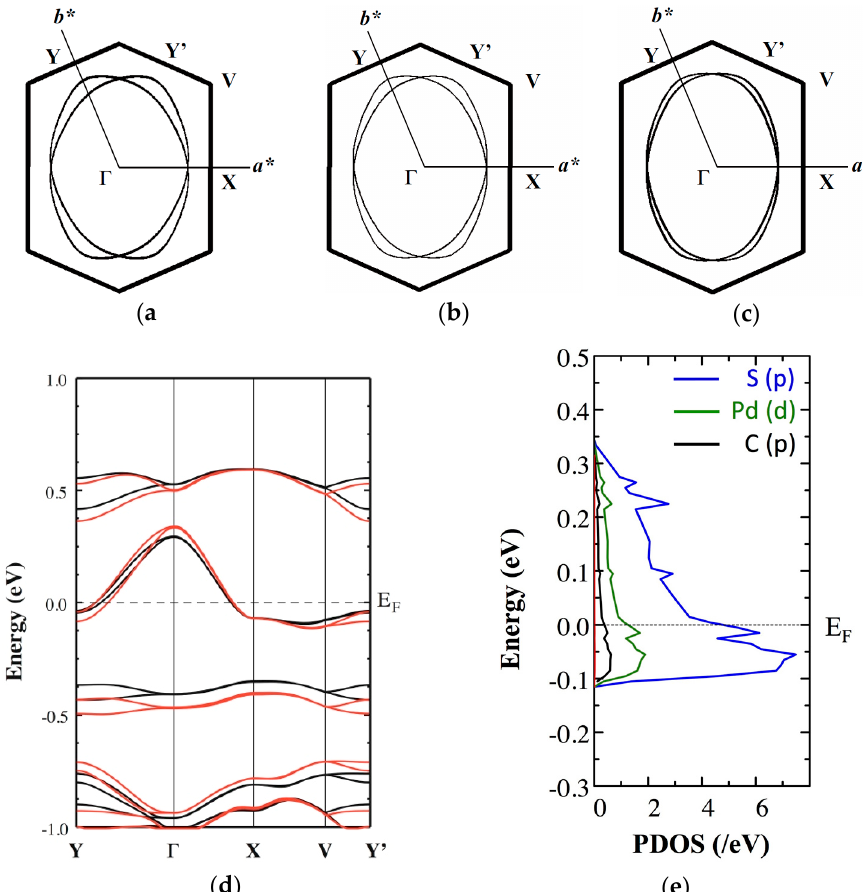
Figure 5. Electronic structure of the EtMe 3 Sb salt calculated by the first-principles DFT method. Fermi surface at 5 K ( a ), 101 K ( b ), and 295 K ( c ). ( d ) Band dispersion at 5 K (red) and 295 K (black). ( e ) Partial density of states (PDOS) at 5 K in the conduction bands for the d-orbitals of Pd (green), the p-orbitals of S (blue), the p-orbitals of C in the dmit ligand (black), and the s- and p-orbitals of C in the EtMe 3 Sb cation (red). The blue and black lines each show the summation of the PDOS of all the S and C atoms belonging to the dmit ligand.